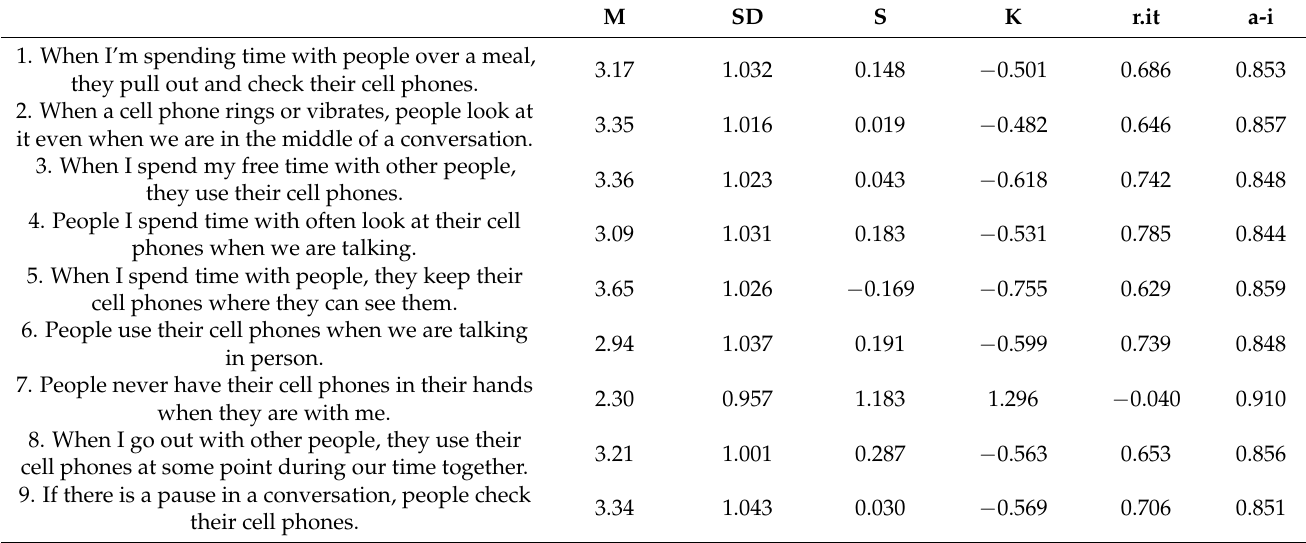
Table 1. Descriptive Statistics and Reliability of Phubbing